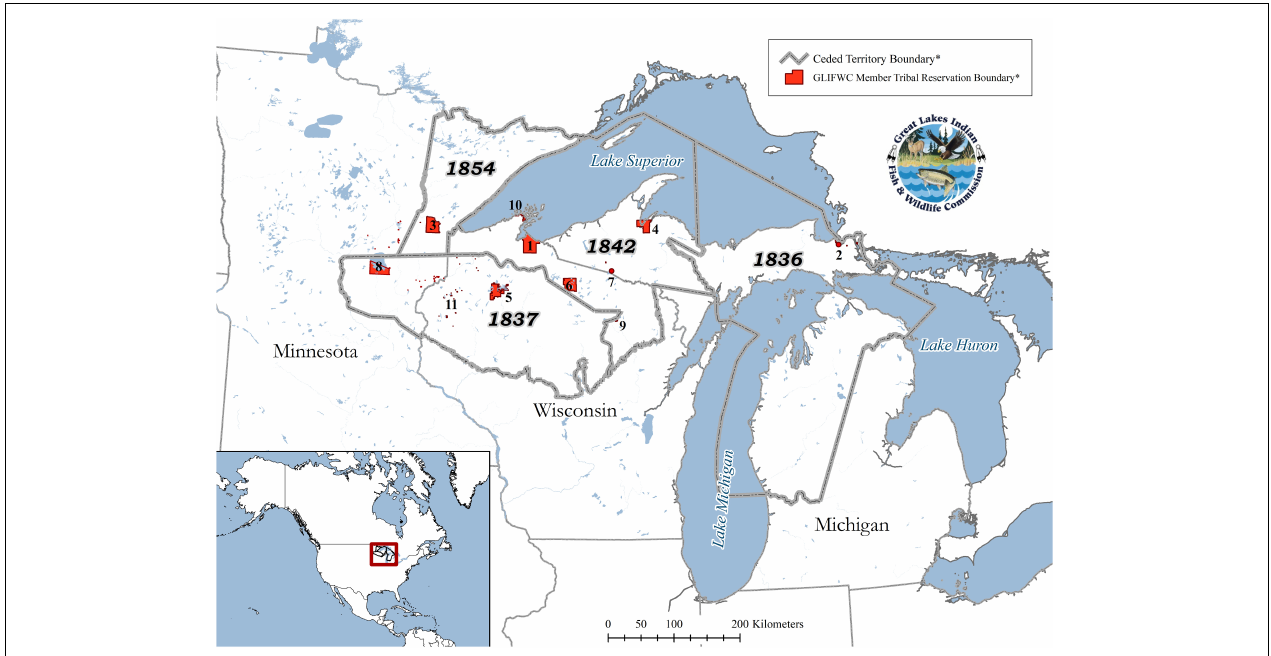
FIGURE 1 | Territories ceded to the United States in the Treaties of 1836, 1837, 1842, and 1854 in which Ojibwe tribes ceded the outlined lands and reserved the rights to hunt, fish, and gather to maintain their lifeway. GLIFWC member tribes are in red [(1) Bad River, (2) Bay Mills, (3) Fond du Lac, (4) Keweenaw Bay, (5) Lac Courte Oreilles, (6) Lac du Flambeau, (7) Lac Vieux Desert, (8) Mille Lacs, (9) Mole Lake, (10) Red Cliff, and (11) St. Croix]. *The ceded territory and reservation boundaries are representations and may not be the legally binding boundary. Map created using Ceded Territories Boundary Version